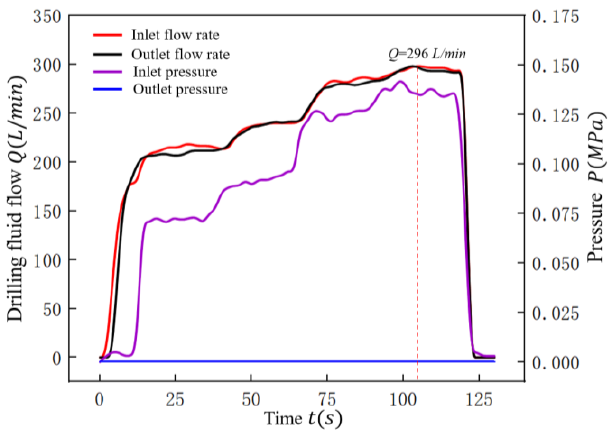
Figure 14. Drilling fluid flow and pressure of Experiment I change with time.